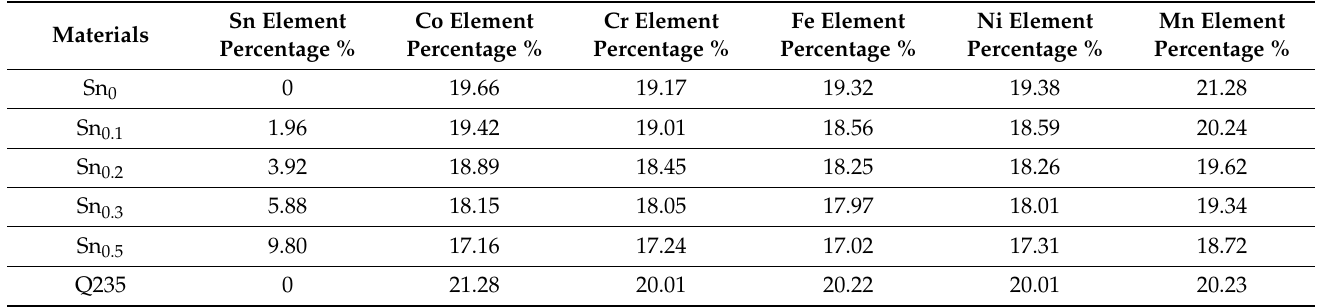
Figure 2. Energy spectrum of CoCrFeNiMn HEA powder. Table 1. Chemical composition of CoCrFeMnNiSn x and Q235 (wt. %).